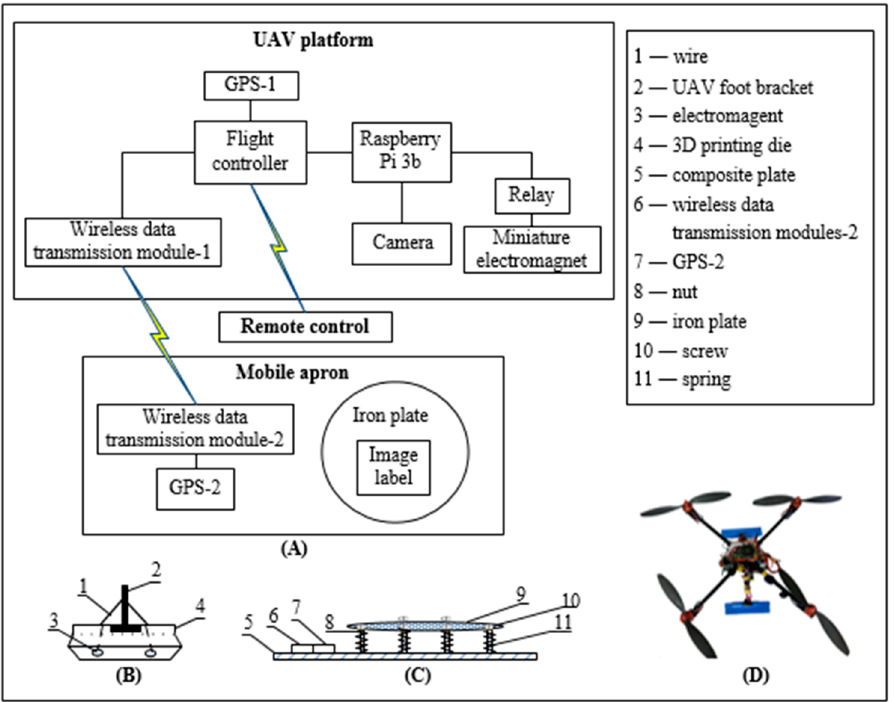
Figure 1. The schematic diagram of unmanned aerial vehicle (UAV) platform: ( A ) system overall hardware structure diagram; ( B ) schematic diagram of electromagnet installation structure; ( C ) mobile apron structural diagram; and ( D ) overhead view of the built UAV.